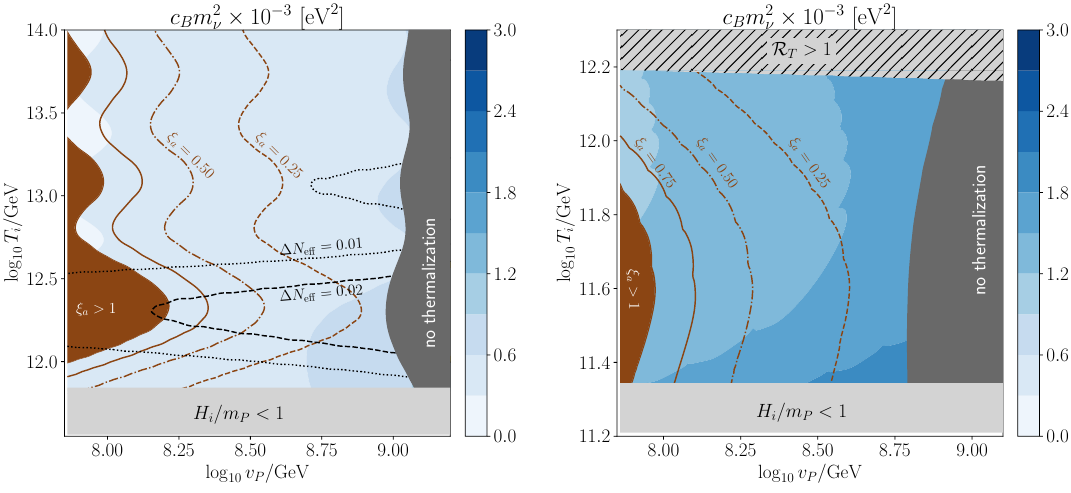
to explain the baryon asymmetry in the n = 10 , m Figure 5 . The values of c B m 2 ν ( n = 8 , m = 10 5 GeV) scenario on the left (right) panel. The thermalization does not complete P in the dark gray region. ∆ N = 0 . 02 ( 0 . 01 ) on the black dashed (dotted) line. The fraction eff of the axion density, ξ := Ω Ω , is 0 . 75 , 0 . 50 , 0 . 25 on the brown solid, dot-dashed, dashed a a / DM lines, respectively, when N = 1 . The axion is overproduced in the brown region. The relative DW importance of the thermal-log term to the mass term, R defined in eq. (B.5), is larger than unity T in the gray hatched